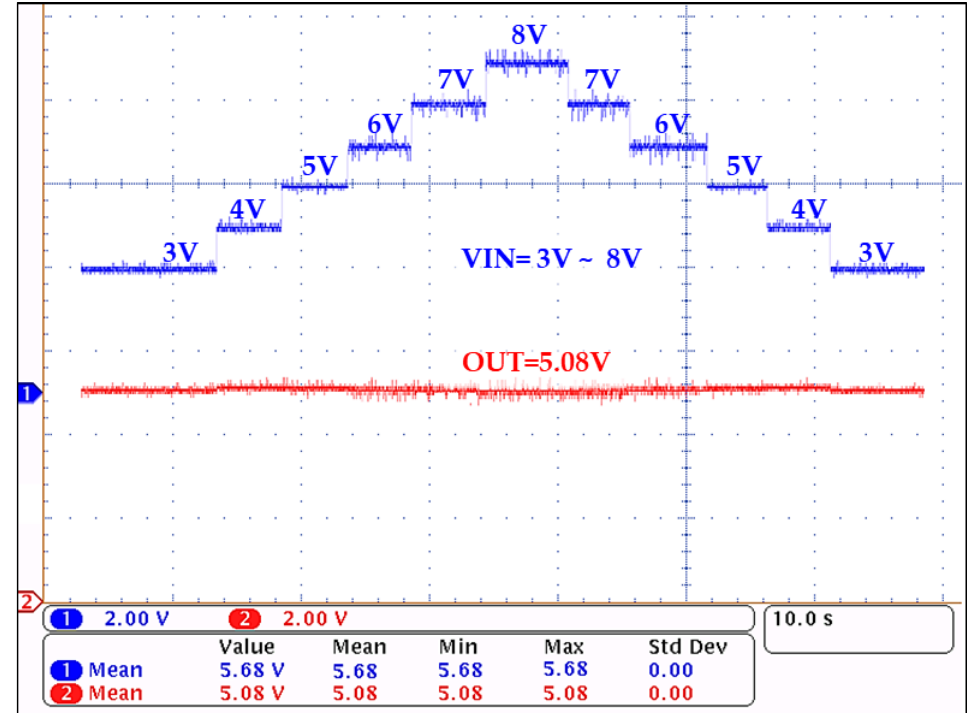
Figure 12. Output regulation over wide input range measurement waveform.